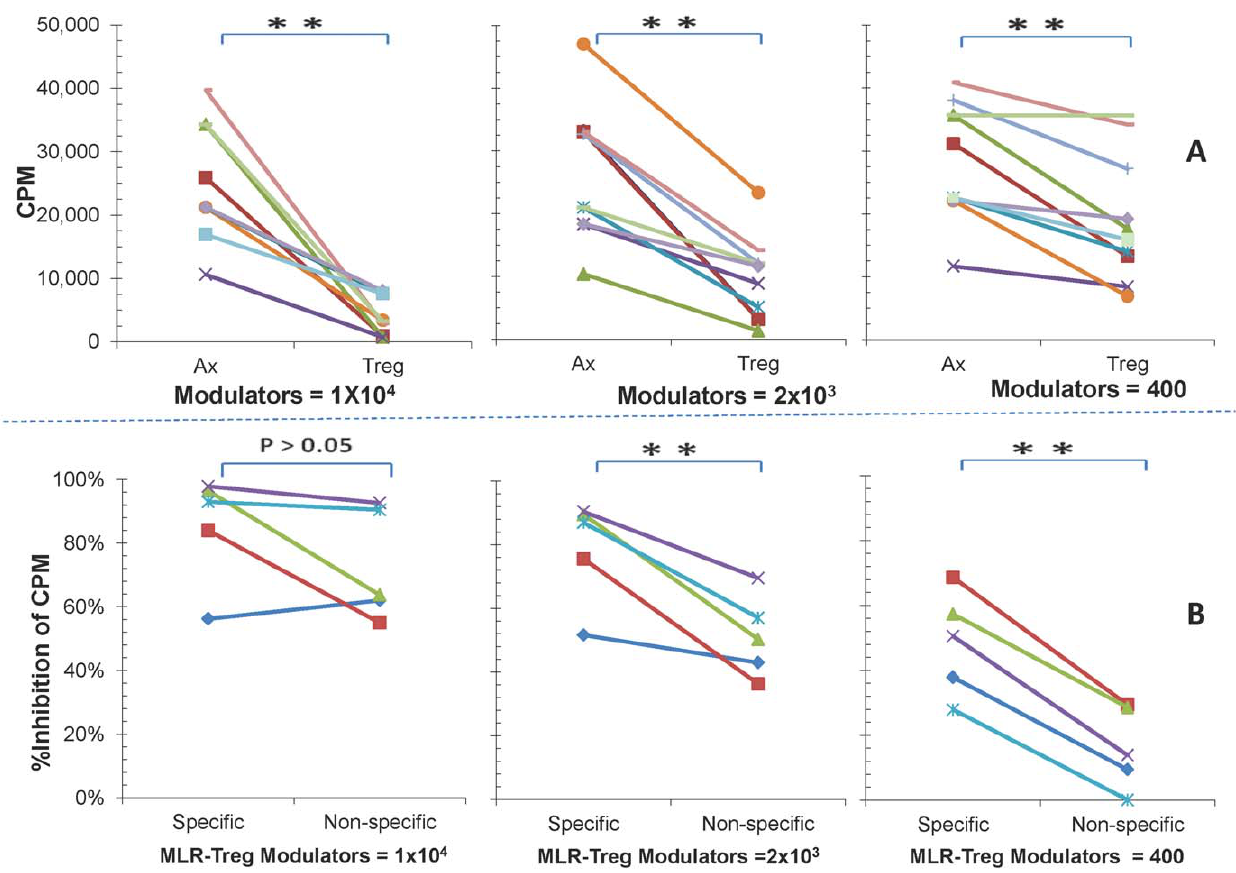
Figure 3. The ability of MLR-Tregs to allospecifically suppress MLR proliferation. MLR-Tregs were added as modulators in descending concentrations of 1 6 10 4 , 2 6 10 3 or 0.4 6 10 3 cells per well to 1 6 10 5 fresh responding PBMC from the same individual as the one from whom MLR-Tregs were generated (i.e., the responders were autologous to MLR-Tregs). These were stimulated with 1 6 10 5 irradiated PBMC and 18-hour 3 H-Thymidine incorporation assays were performed (as diagrammatically shown in Figure 1; step # 2, left) and the data are shown as: (A) CPM: 3 H- TdR uptake in MLR of the responder to the original stimulator used in generating the MLR-Tregs in the presence of the indicated number of modulator cells. Note that inhibition by MLR-Treg modulators is demonstrated by the differences between modulator Treg points, (right side), vs. fresh Ax (autologous irradiated PBMC) added as modulator controls (left side) (**=p , .01; n=10). (B) Percentage inhibition: The CPM values (from A) were converted to percent inhibition (Tregs vs. Ax; see Methods for the formula) and allospecific vs. non-specific inhibition is shown. For allospecific inhibition the stimulators were from the original stimulators used for generating MLR-Tregs and for non-specific inhibition the stimulator PBMC were from a different totally HLA mismatched (third party) individual. Note the drastic decrease in the inhibitory effect by MLR-Tregs in the non-specific culture combinations as the modulator cell concentrations decreased (**=p , 0.01; n=5).